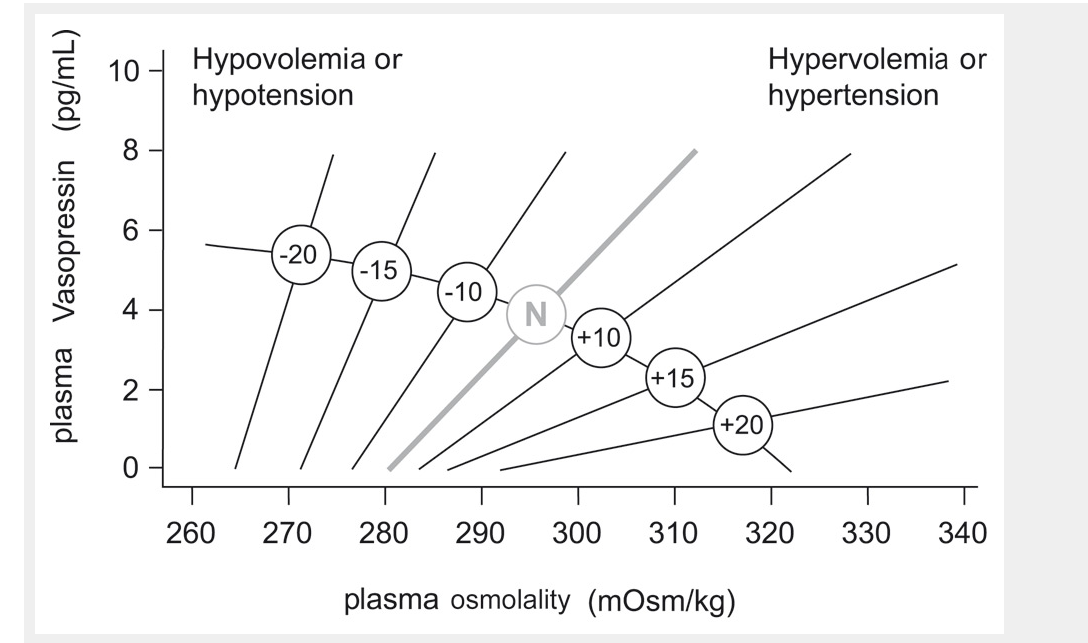
Figure 3 Schematic representation of the relationship between plasma vasopressin and plasma osmolality in the presence of differing states of blood volume and/or pressure. The line labelled N represents normovolaemic normotensive conditions. Minus numbers to the left indicate percent fall, and positive numbers to the right, percent rise in blood volume or pressure.